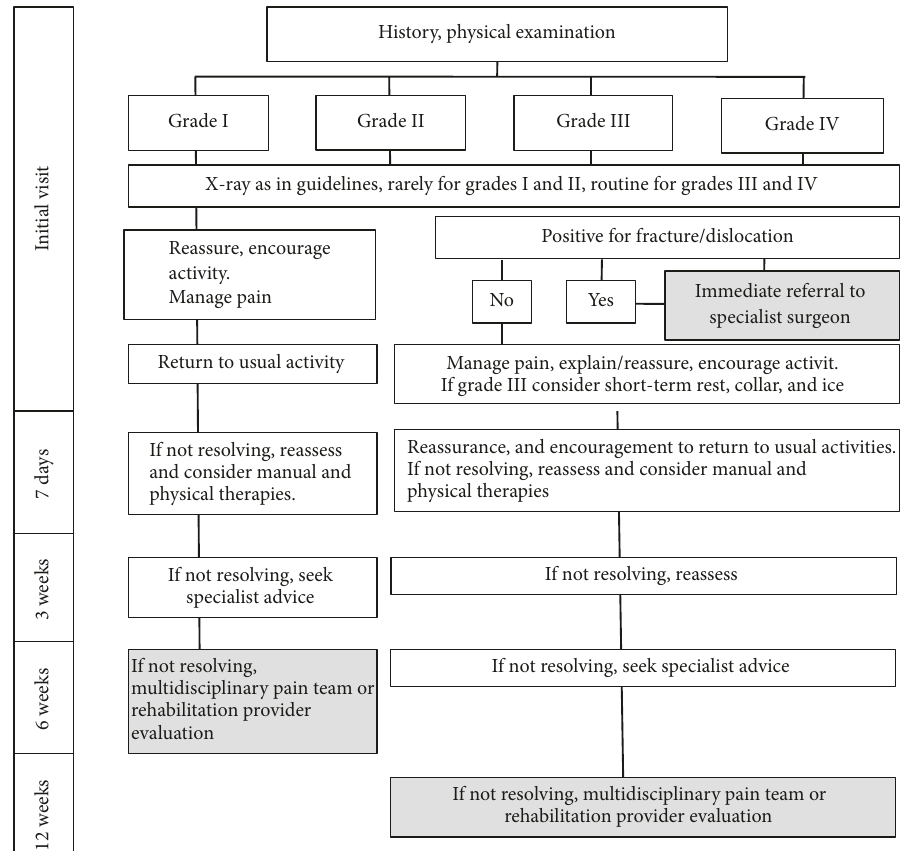
Figure 2: Clinical practice guidelines by Quebec Task Force on whiplash-associated disorders